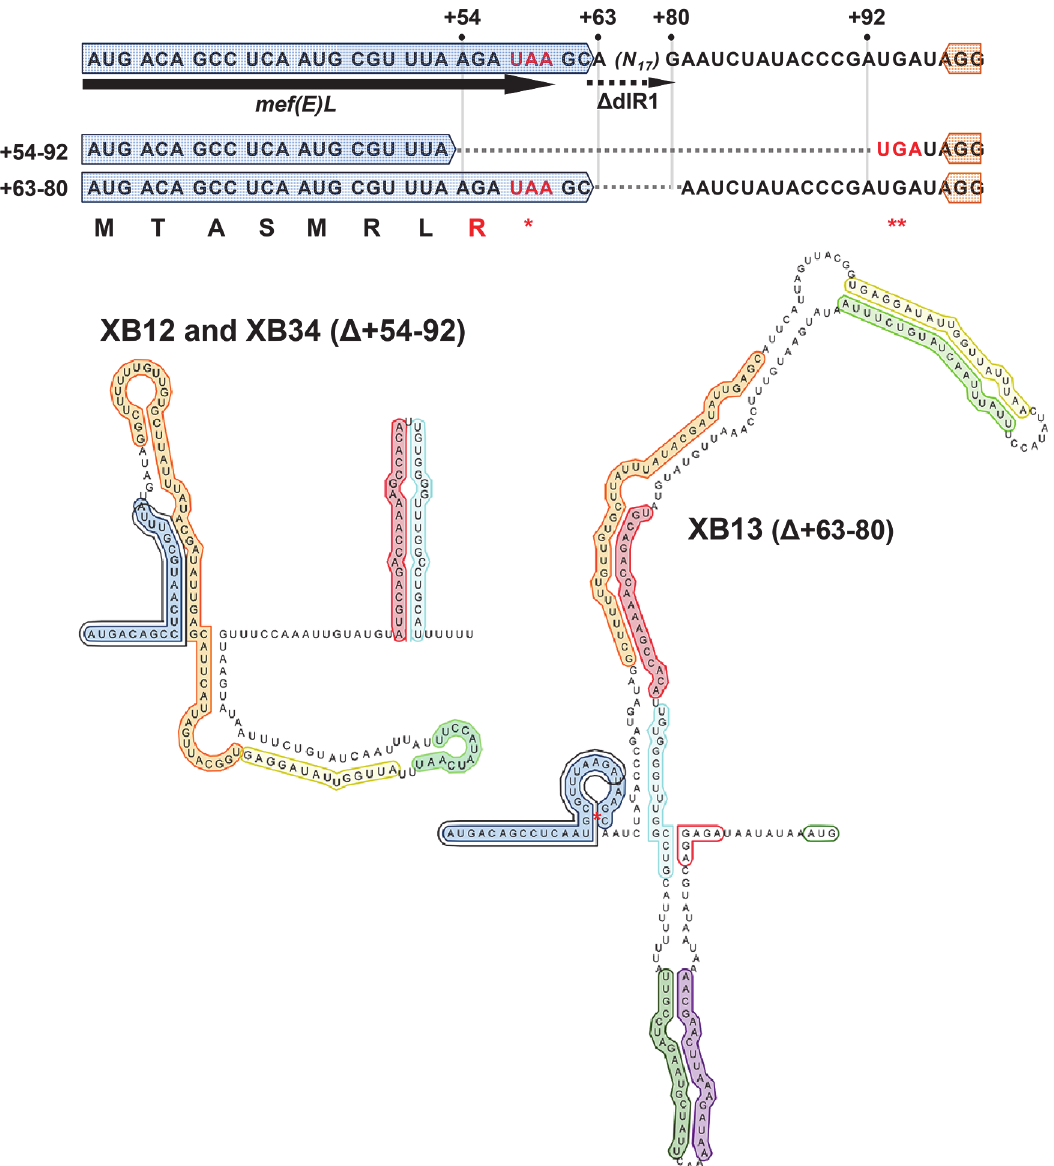
Fig 5. Stem-loop R1/R2 and mef(E)L . The sequence and predicted structure of the 5 ’ end of mef(E)/mel transcripts with the Δ +54 – 92 and Δ +63 – 80 mutations. Nucleotides are numbered relative to the mef(E)/mel transcriptional start (+1). The inverted repeats are annotated as described for Fig. 3. A single asterisk signifies a stop codon of the full-length mef(E)L . Double asterisks indicate the stop codon generates by the Δ +54 – 92 mutation. The dashed arrow indicates the location of the first unit of the distal inverted repeats